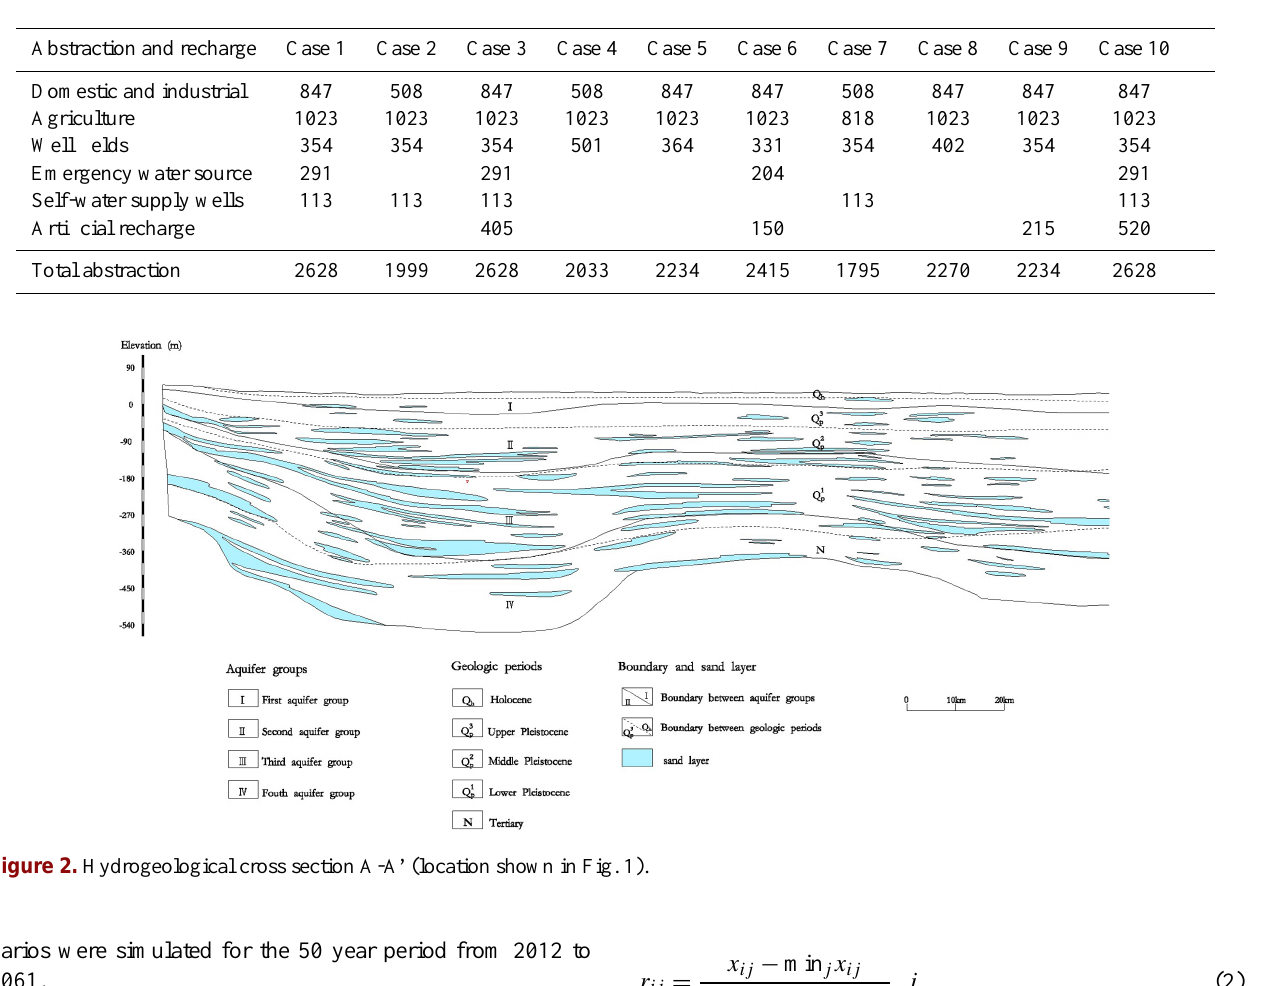
Table 1. Groundwater regulation scenarios (10 6 m 3 a − 1 ).